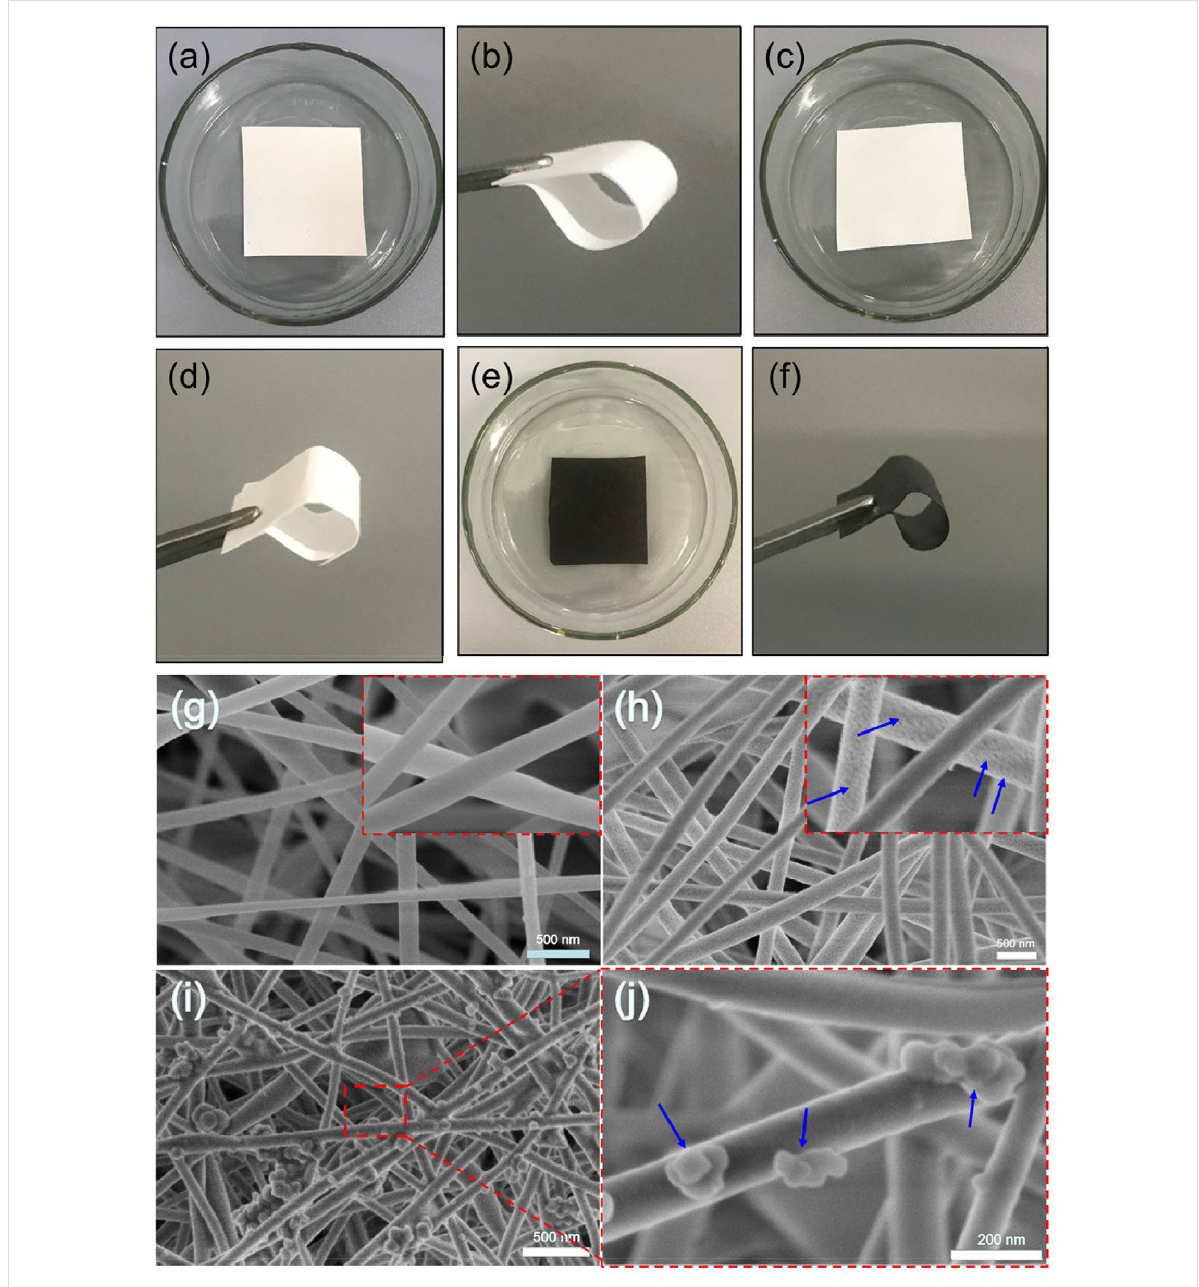
Figure 5: The flexibility of the as-prepared PVA/TEOS membrane (a, b), SiO 2 nanofiber membrane (c, d) and Pd-decorated polydopamine-SiO 2 /PVA electrospinning nanofiber membrane (e, f). FE-SEM images of the as-prepared PVA/TEOS nanofiber membrane (g), SiO 2 nanofiber membrane (h), and Pd-decorated polydopamine-SiO 2 /PVA nanofiber membrane with different magnifications (i, j). Figure 5 was reprinted from [83] Journal of Cleaner Production, vol. 275, by H. Yin; J. Zhao; Y. Li; L. Huang; H. Zhang; L. Chen, “A novel Pd decorated polydopamine-SiO 2 /PVA electrospun nanofiber membrane for highly efficient degradation of organic dyes and removal of organic chemicals and oils”, article no. 122937, Copyright (2020), with permission from Elsevier. This content is not subject to CC BY 4.0.